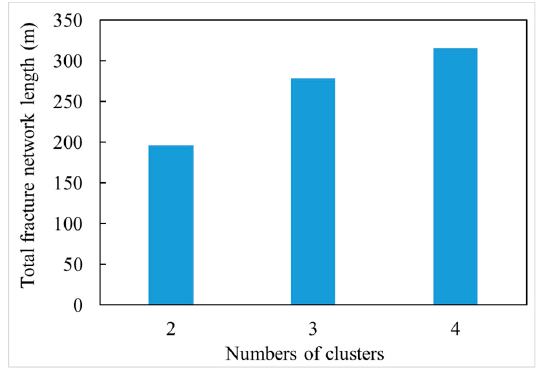
Figure 17. Fracture network lengths corresponding to different numbers of clusters.